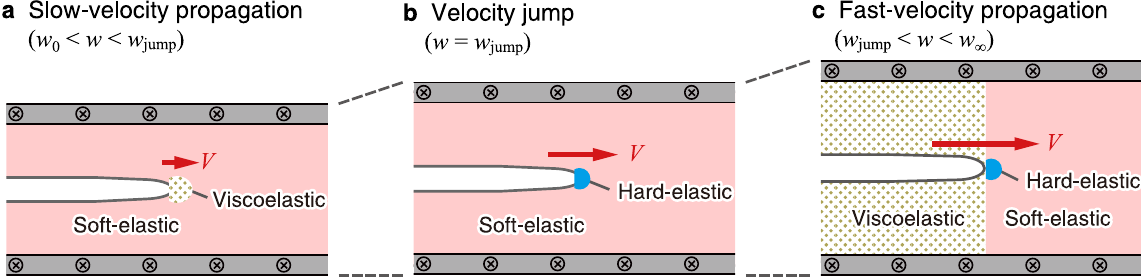
Figure 6. Physical pictures on the crack propagation revealed by the present exact solution. We draw the three illustrations based on Fig. 5. ( a ) The slow-velocity propagation is characterized by viscous dissipation in the vicinity of the crack tip. ( b ) The velocity jump induced by emergence of a hard-elastic regime (as a result of a dynamic glass transition) in the close vicinity of the crack tip. ( c ) The fast-velocity propagation is characterized by viscous dissipation on the rear side (with the hard-elastic regime in the close vicinity of the crack tip). Note that away from the crack tip viscous dissipation in the viscoelastic regime decays with the distance from the tip (see the text for